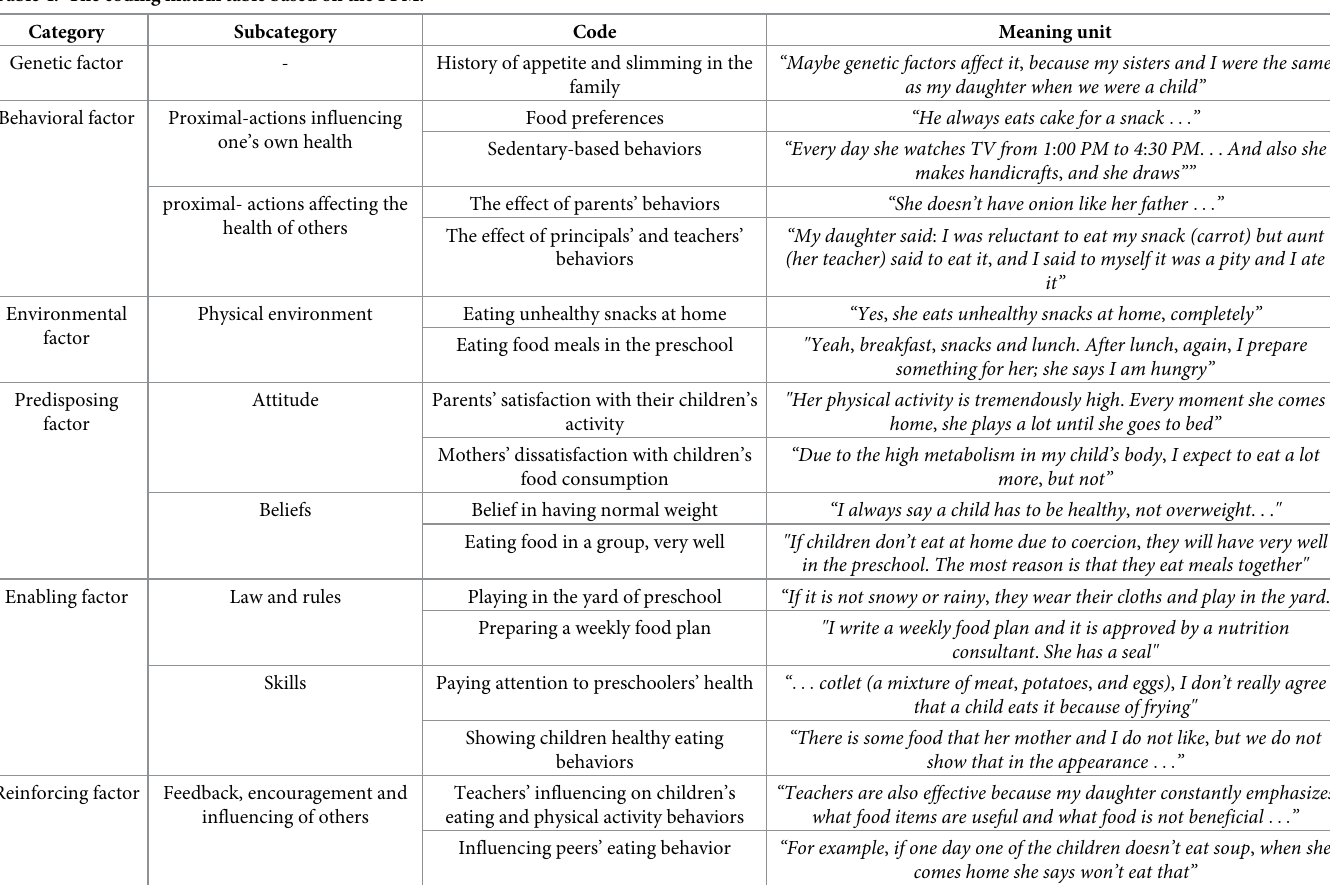
Table 4. The coding matrix table based on the